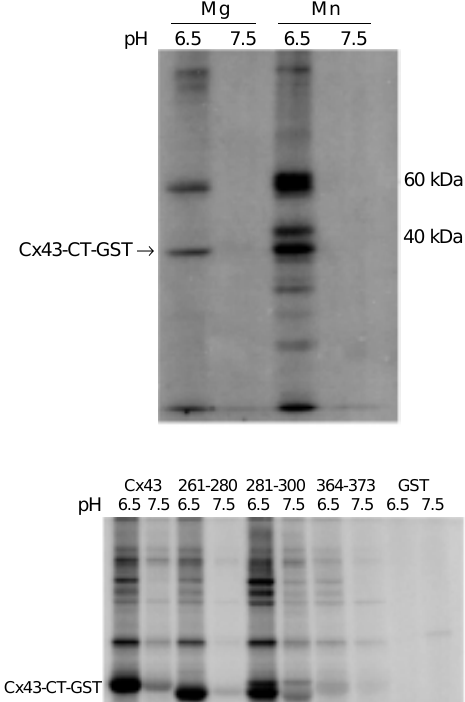
Figure 5 - Analysis of phospho- rylation of Cx43 mutants.